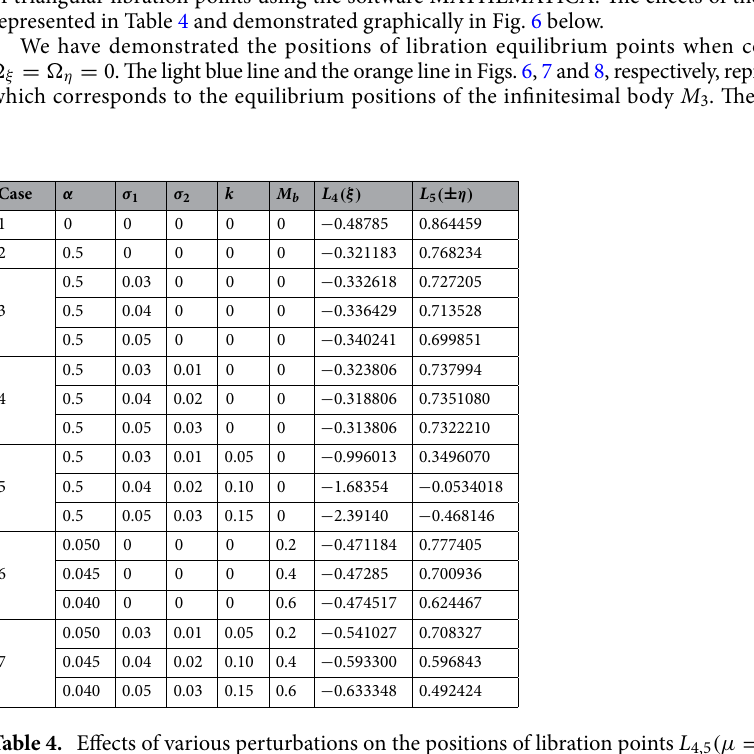
Table 4. Effects of various perturbations on the positions of libration points L 4,5 (µ = 0.01215,